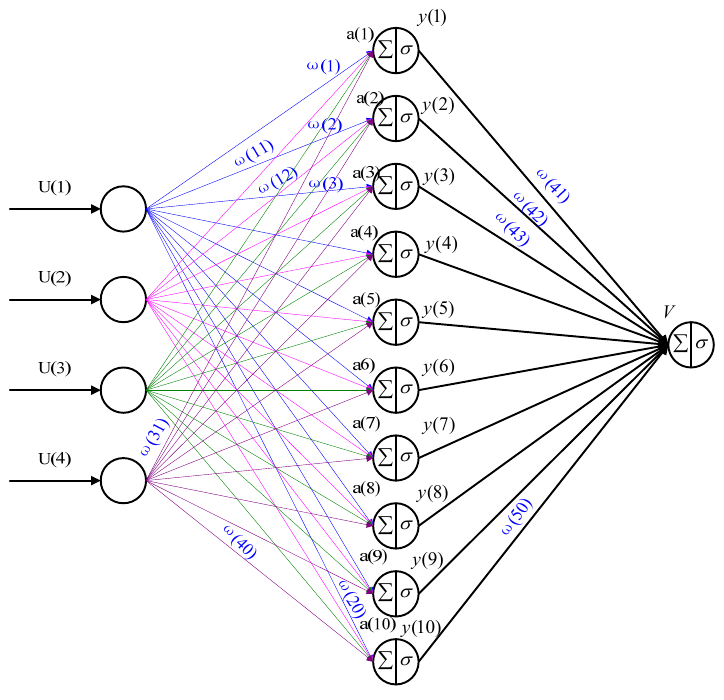
Figure 3. Architecture of the